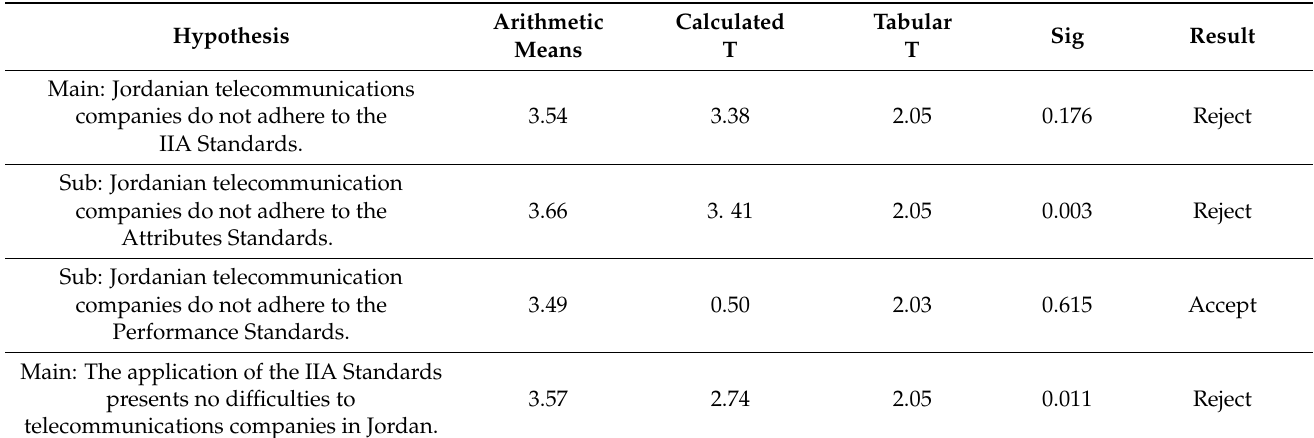
Table 7. Hypotheses testing outcomes (One Sample